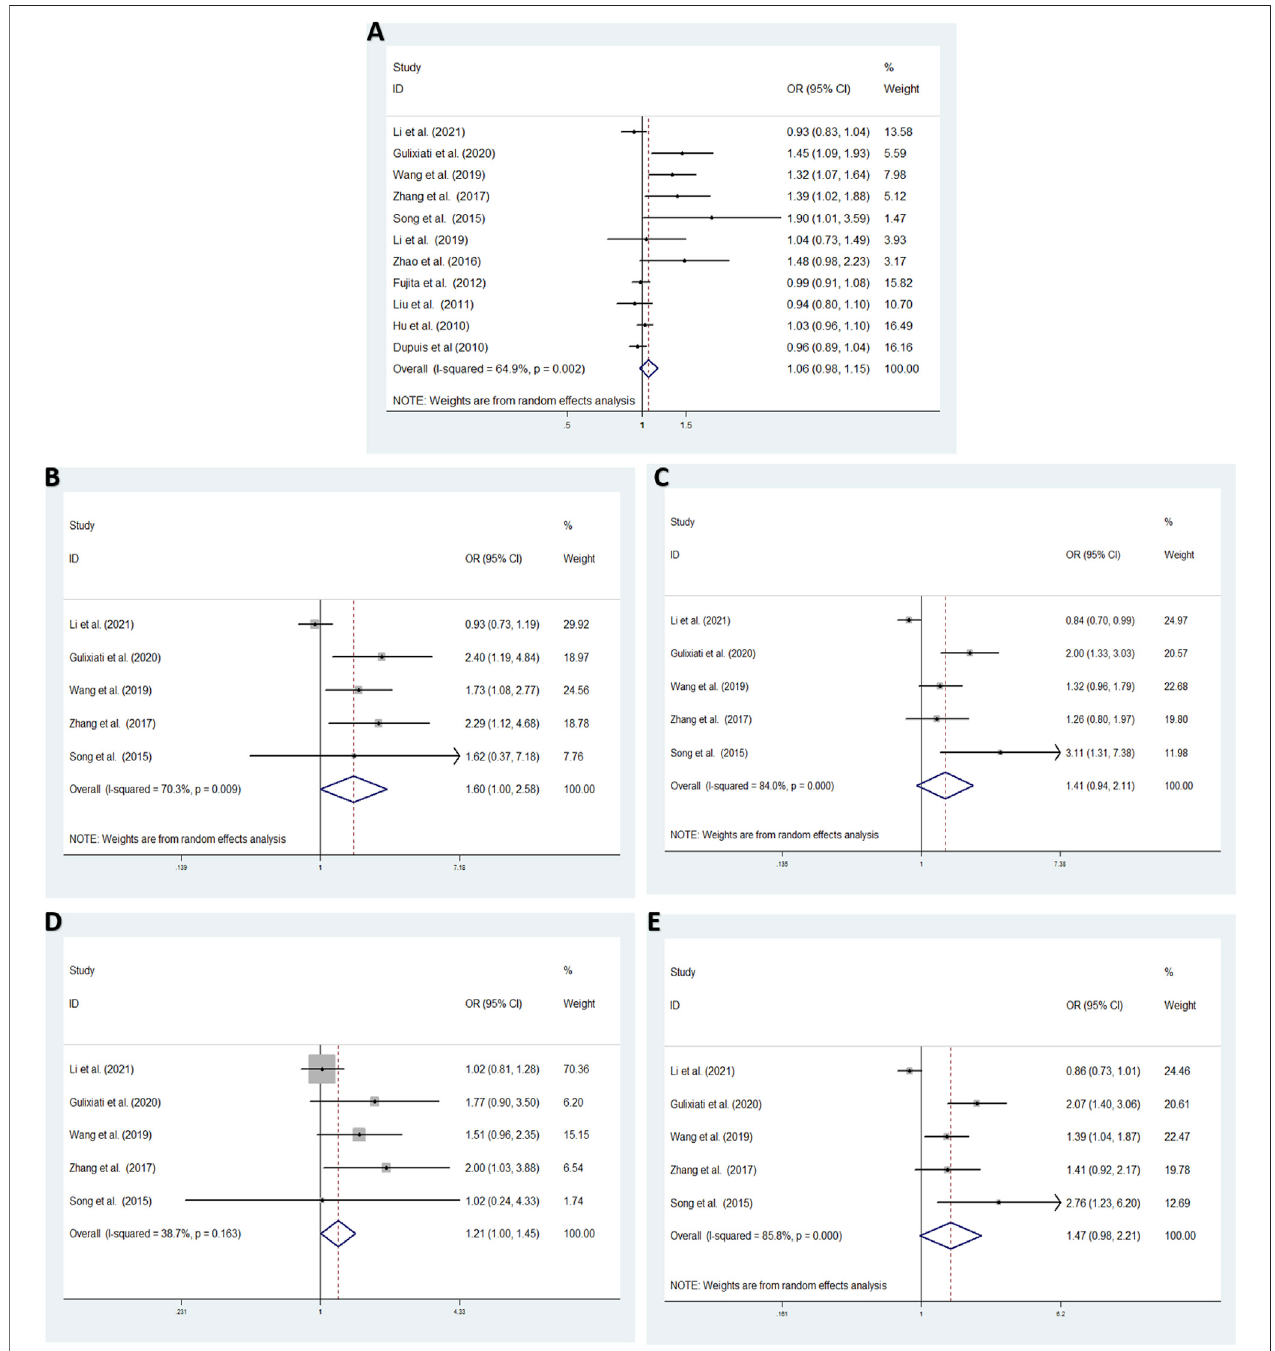
FIGURE 4 | Meta-analysis for the association between the IGF-1 rs35767 and T2DM susceptibility after omitting Gouda ’ s study. (A) Allele model, T vs. C (random effects model). (B) Additive model (homozygote comparisons): TT vs. CC. (random effects model). (C) Additive model (heterozygote comparisons): TC vs. CC (random effects model) (D) Recessive model, TT vs. CC + CT ( fi xed effects model) (E) Dominant model, TT + CT vs. CC (random effects model). OR: odds ratio, CI: con fi dence interval, I-squared: measure to quantify the degree of heterogeneity in